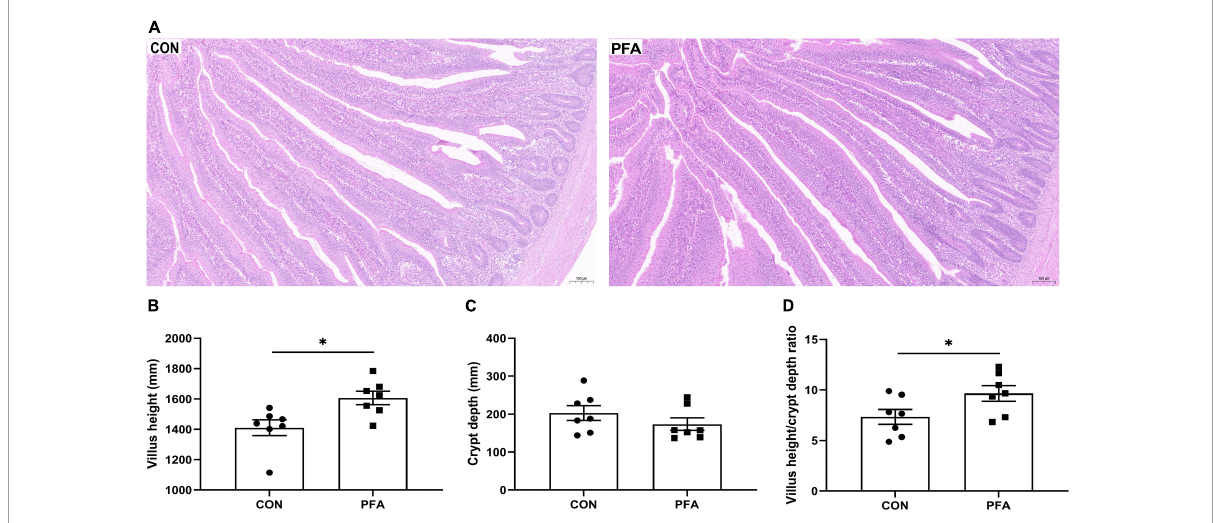
FIGURE1 Effect of dietary paraformic acid supplementation on intestinal morphology in broiler chickens. (A) Hematoxylin and eosin photomicrographs obtained at 100 × magnification; (B) Villus height; (C) Crypt depth; (D) Villus height/crypt depth ratio. CON, broiler chickens fed basal diet; PFA, broiler chickens fed basal diet supplemented with 1,000 mg/kg paraformic acid. Values are mean ± standard error ( n = 7). Differences between treatments were displayed by ∗ P < 0.05.